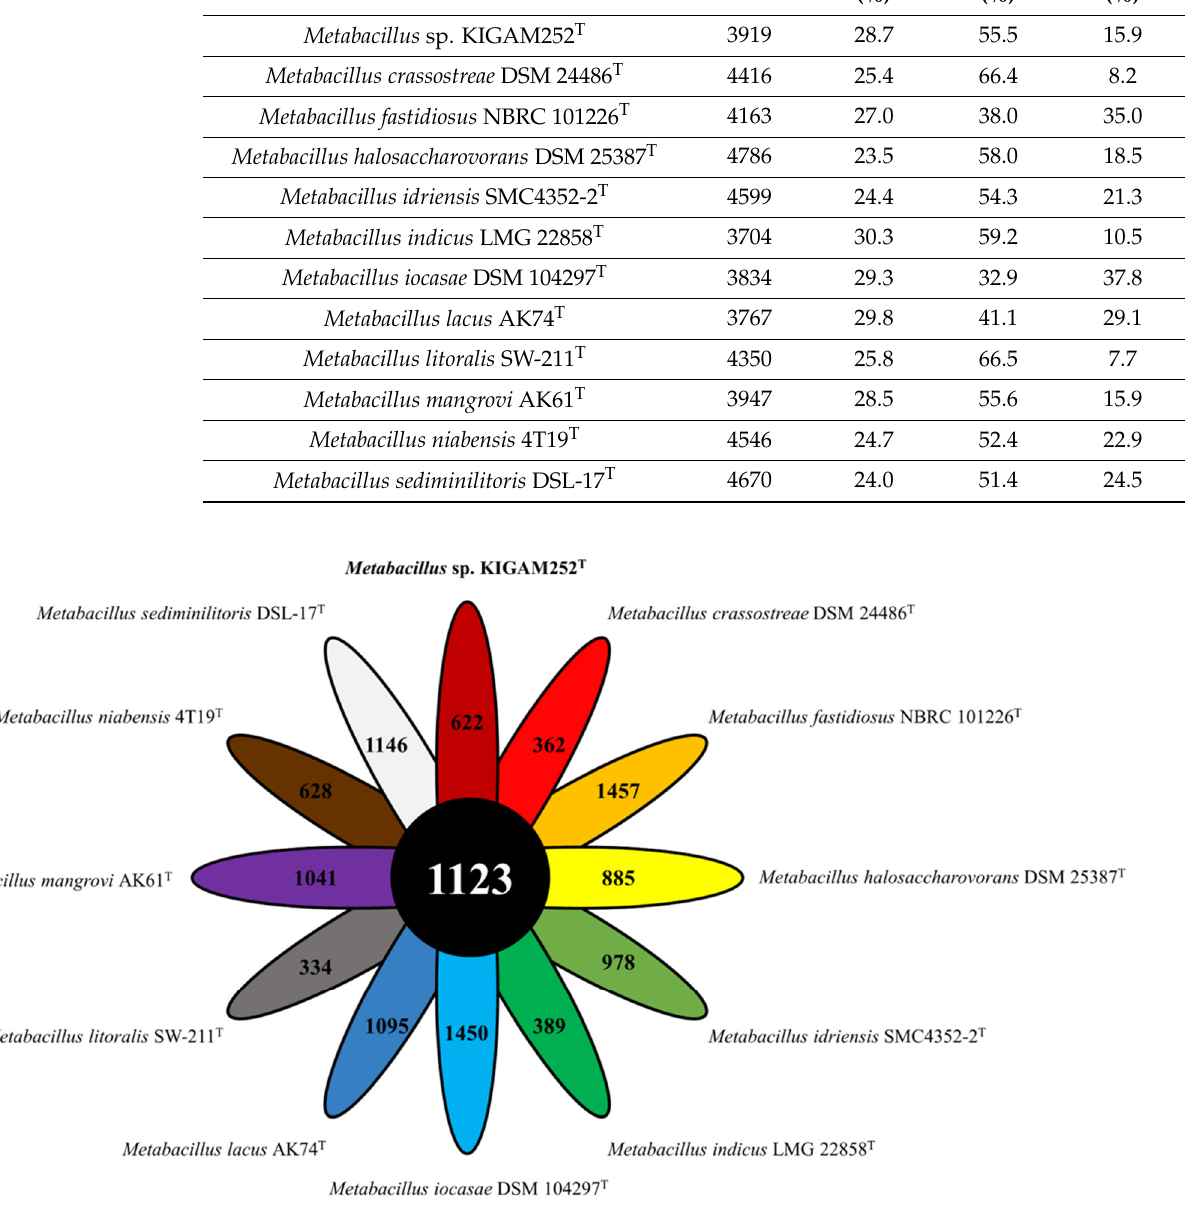
Figure 3. Flower plot indicating the core and strain-specific POGs of the novel strain KIGAM252 T and of other species of the genus Metabacillus ; M. mangrovi AK61 T , M. indicus LMG 22858 T , M. idriensis SMC4352-2 T , M. lacus AK74 T , M. sediminilitoris DSL-17 T , M. fastidiosus NBRC 101226 T , M. halosaccharovorans DSM 25387 T , M. niabensis 4T19 T , M. crassostreae DSM 24486 T , M. litoralis SW-2211 T , and M. iocasae DSM 104297 T .